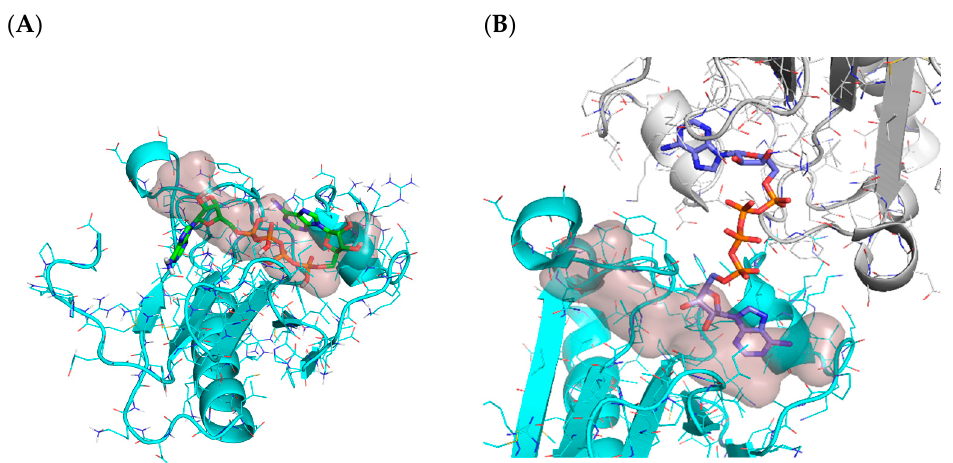
Figure 8. ( A ) hiTanimoto receptor for target 6j65. The solution selected by the pipeline is represented as sticks. ( B ) Protein dimer in PDB code 6j65. The crystalized ligand is represented as sticks. For both figures, the reference cavity provided by 3decision is shown as transparent surface.